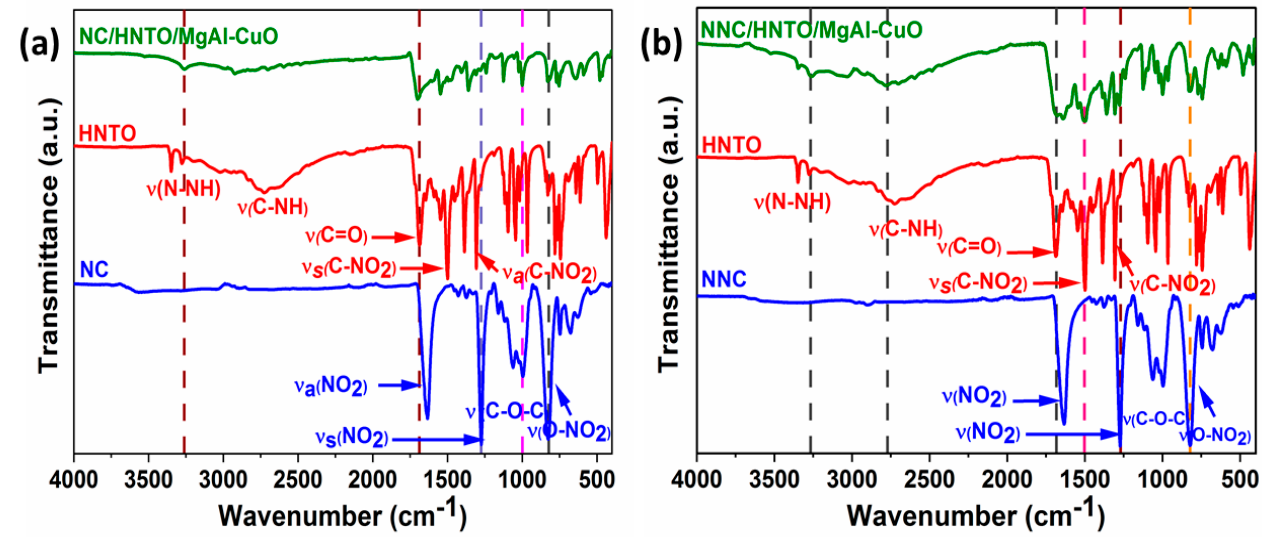
Figure 1. FTIR spectra of ( a ) NC/HNTO/MgAl-CuO composite; ( b ) NNC/ HNTO/MgAl-CuO composite.